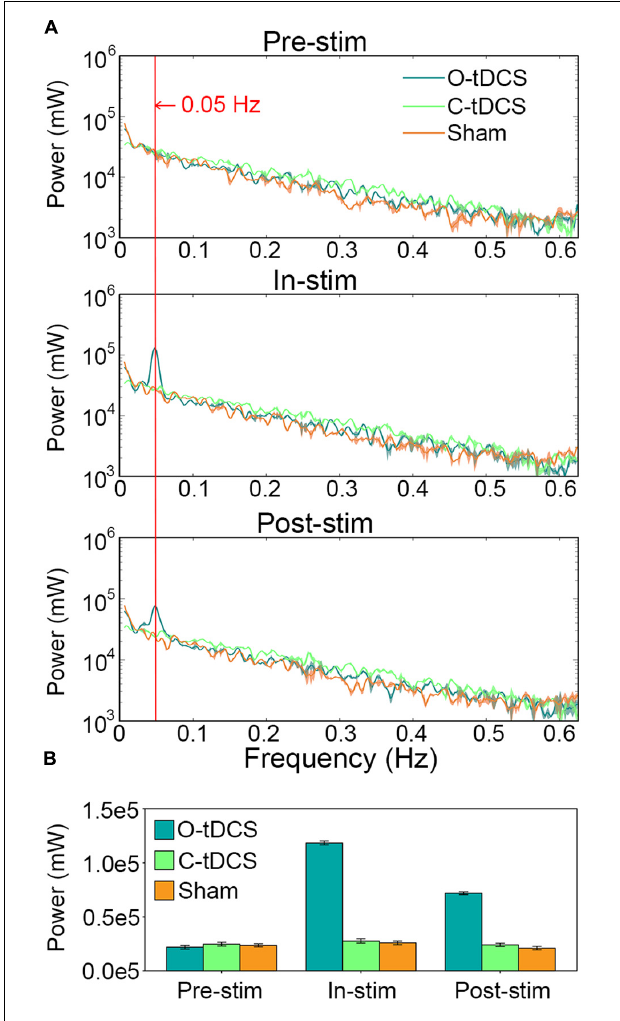
FIGURE 4 | The O-tDCS enhanced the power of RT oscillations at the stimulation frequency. (A) The power spectrum of RT fluctuations. (B) The power at 0.05 Hz. Lines and charts show the mean value of all subjects. Shadows and error bars show the 95% confidence intervals.